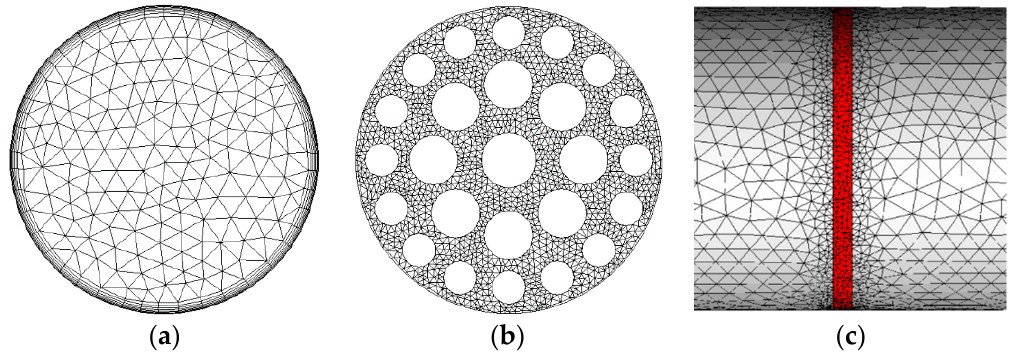
Figure 12. The grid in the vicinity of the FC and boundary layer. ( a ) The boundary layer grid; ( b ) The greatly increased grid